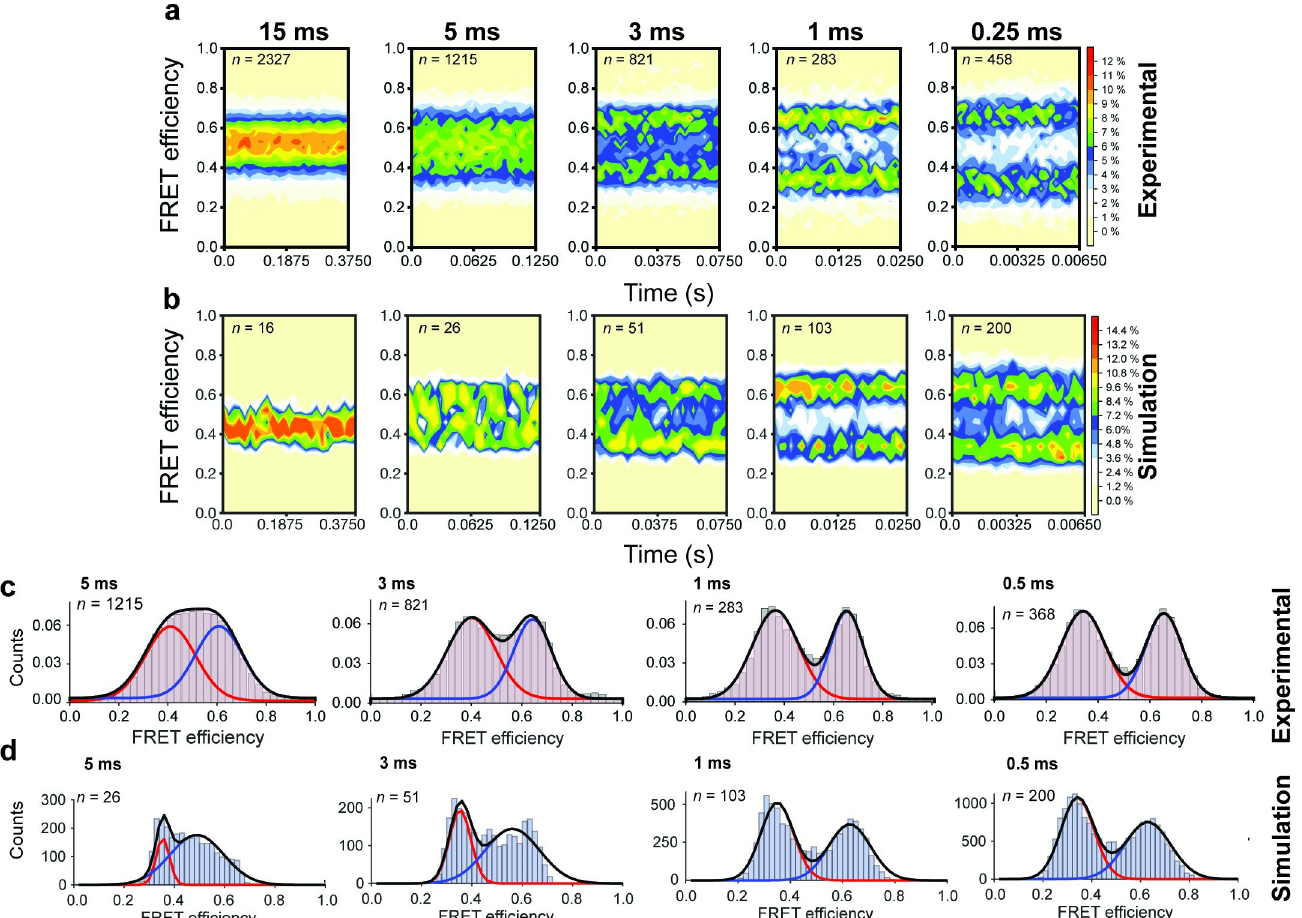
Fig 3. Population level correlation of smFRET and MD simulation FRET distributions. (a) smFRET traces were summed into FRET-time contour plots to show the distribution of FRET populations at 15, 5, 3, 1, and 0.25 ms camera exposure times [70]. (b) Contour plots of MD simulations at the equivalent exposure times (to achieve required sampling for 15ms exposure, 7 simulation trajectories were combined into one trajectory). (c) Histograms of the smFRET experiments (bars) fitted to a two gaussian functions (lines) to identify distinct states with data obtained using TIRF imaging of immobilized particles [70]. (d) Histograms of MD simulations at the equivalent exposure times as smFRET experiments. At 5 and 3 ms sampling, a 3 Gaussian fit was used as an intermediate population between the two FRET states is observed.